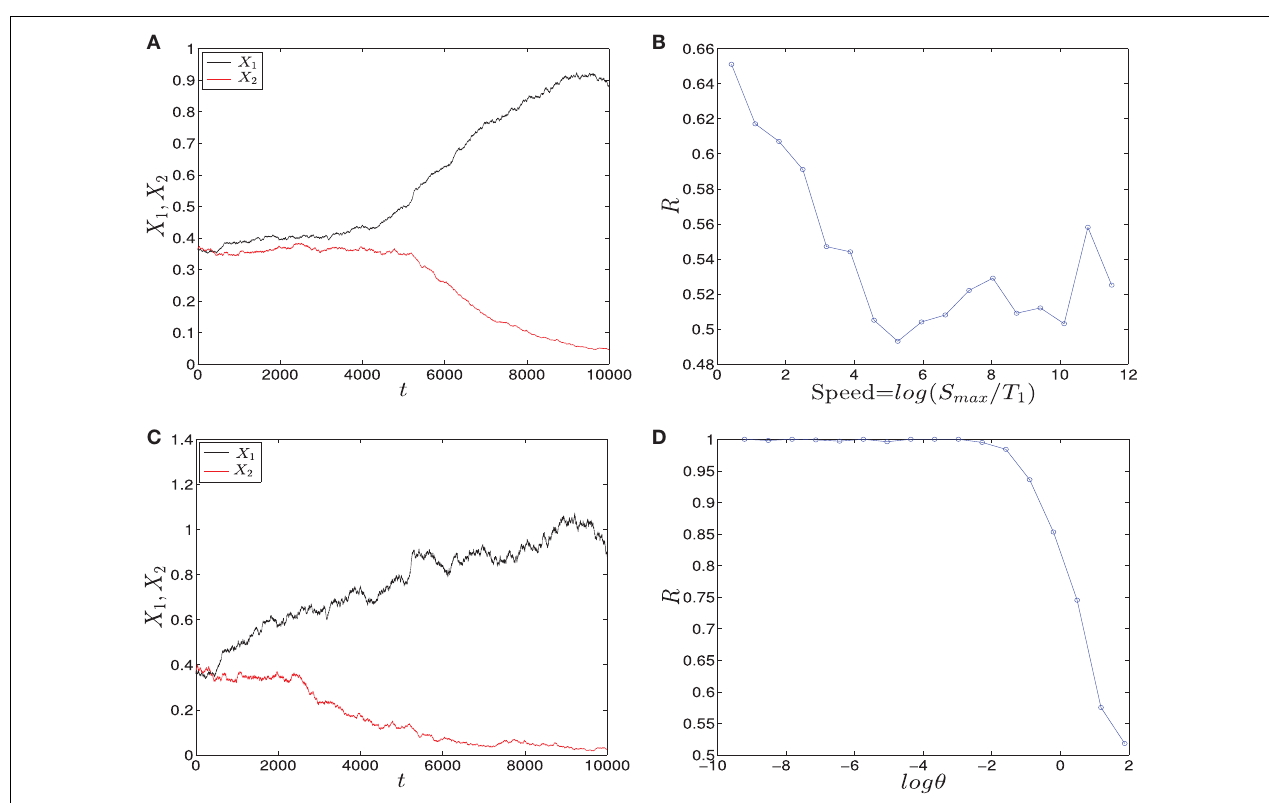
speed is increased, the ratio R tends to 0.5.Thus, increasing the speed increases the symmetry in the switch. (D) The effect of speed with the adaptation form of signals. Decreasing the speed gives ratio R tending to 0.5. Surprisingly, now decreasing the speed increases the symmetry in the switch. Parameters in (A) , (B) are A = 2.5, S max = 10, (C,D) h 1 = h 2 = 10, v = 10, and for all we have a 1 = a 2 = 0.05, b 1 = b 2 = 0.45, r = 0.5, k 1 = k 2 =